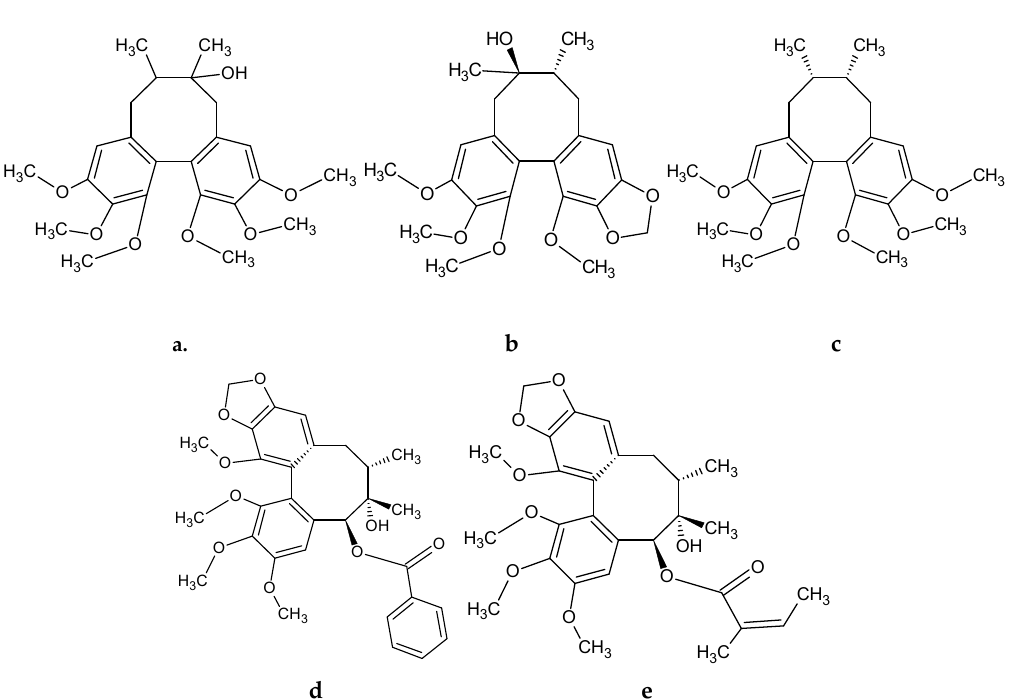
Figure 1. Example structural formulas of abundant S. rubriflora dibenzocyclooctadiene lignans: ( a ) schisandrin; ( b ) gomisin A; ( c ) deoxyschisandrin; ( d ) schisantherin A; ( e ) schisantherin B. Structural formulas drown in: ACD/ChemSkech (Freeware), version 12.00, Advanced Chemistry Development, Inc., Toronto, ON, Canada, www.acdlabs.com, 2010.